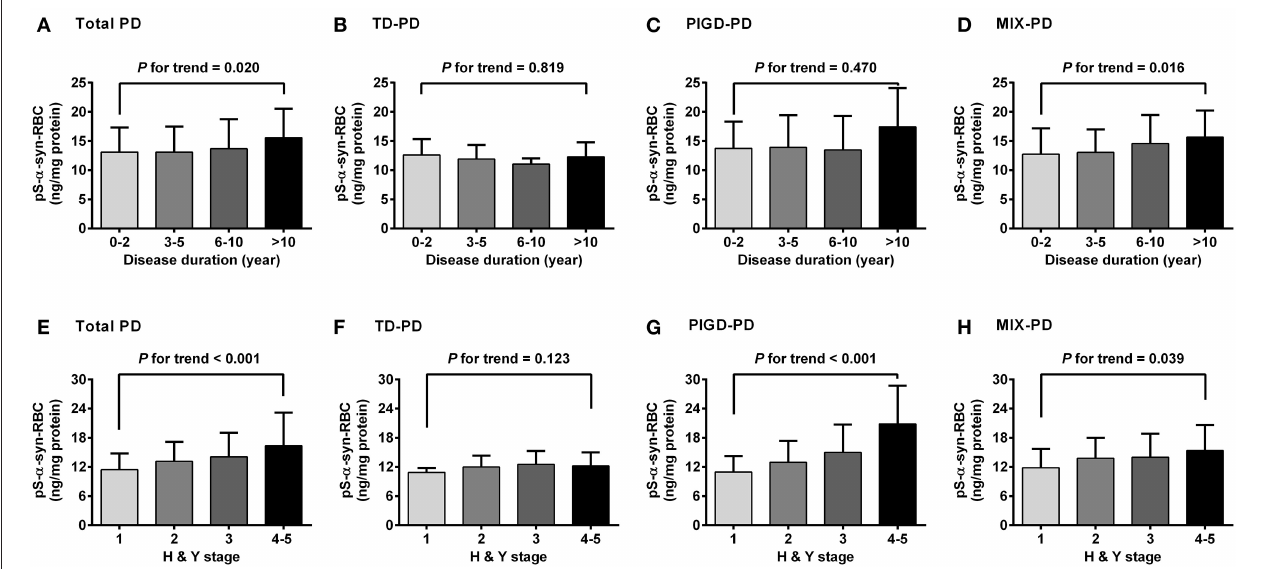
FIGURE 3 | Correlations of pS- α -syn-RBC with disease duration (A–D) and HandY stages (E–H) of Parkinson’s disease and its motor subtypes. Trend was analyzed by using one-degree-freedom linear term. TD-PD, Parkinson’s disease (PD) subtype with tremor dominant phenotype; PIGD-PD, PD subtype with postural instability and gait difficulty (PIGD)-dominant phenotype; MIX-PD, PD subtype with intermediate phenotype between TD and PIGD.